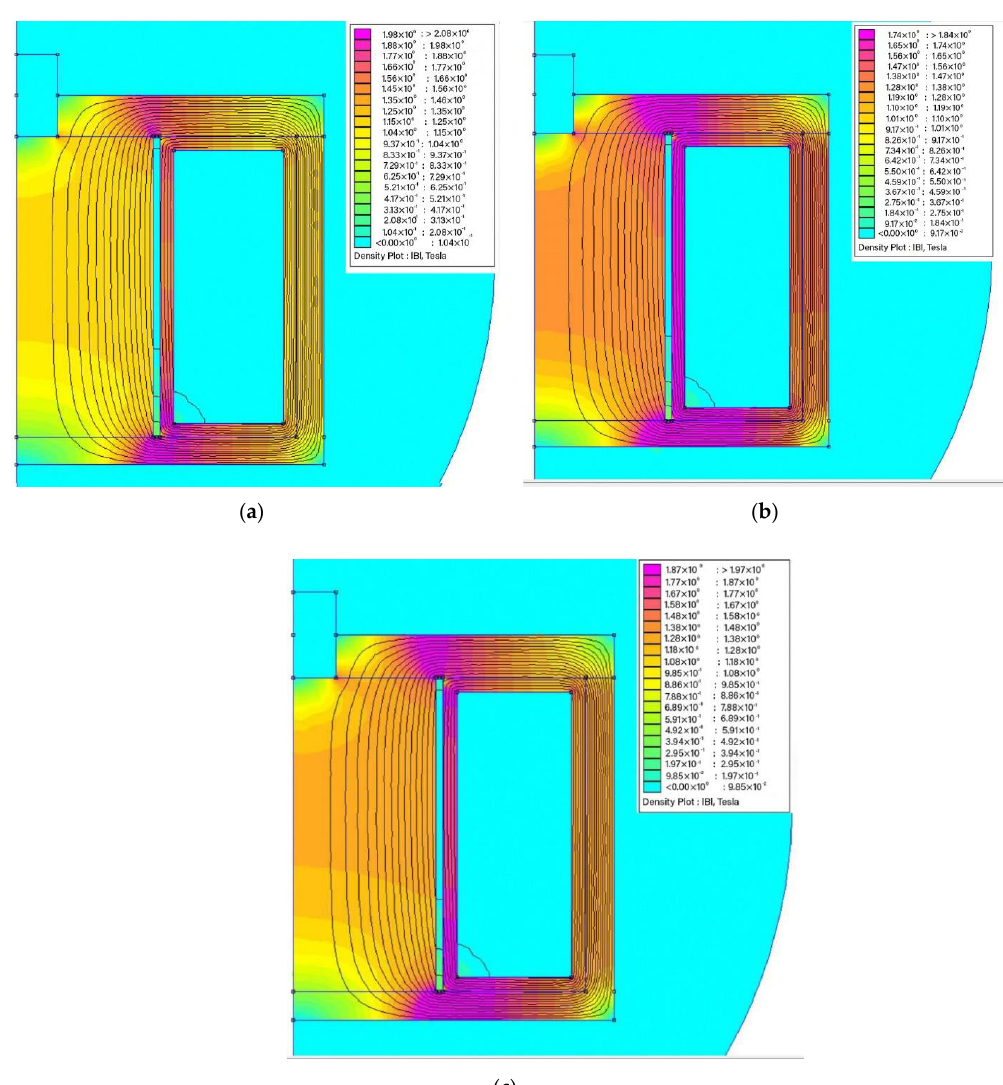
Figure 4. The magnetic fields distribution ( a ) 0.4 A, ( b ) 0.8 A, and ( c ) 1.2 A.